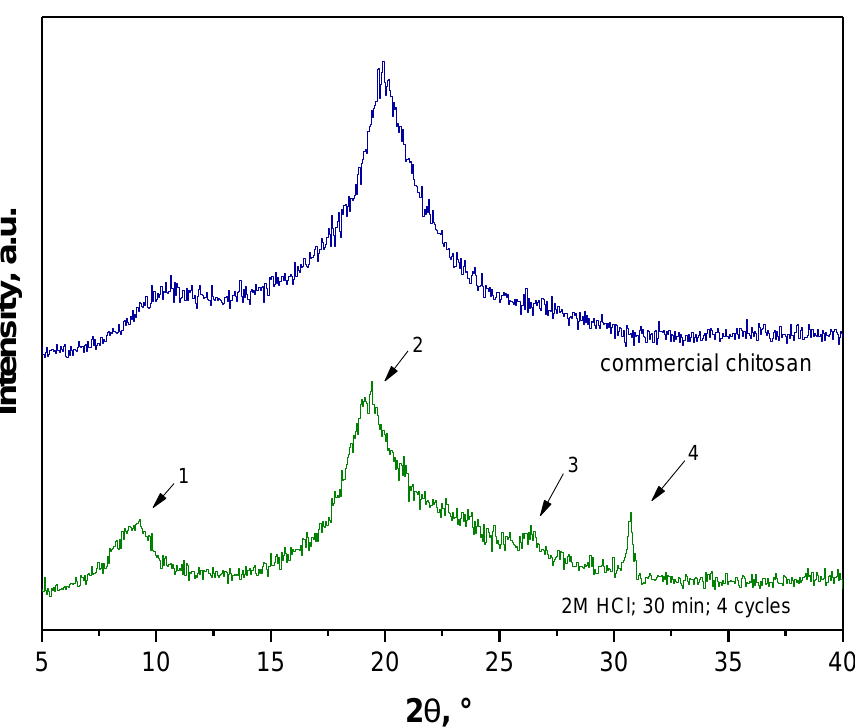
Figure 4. XRD diffraction patterns of commercial chitosan (blue) and selected fraction obtained using the most favorable parameters (green).